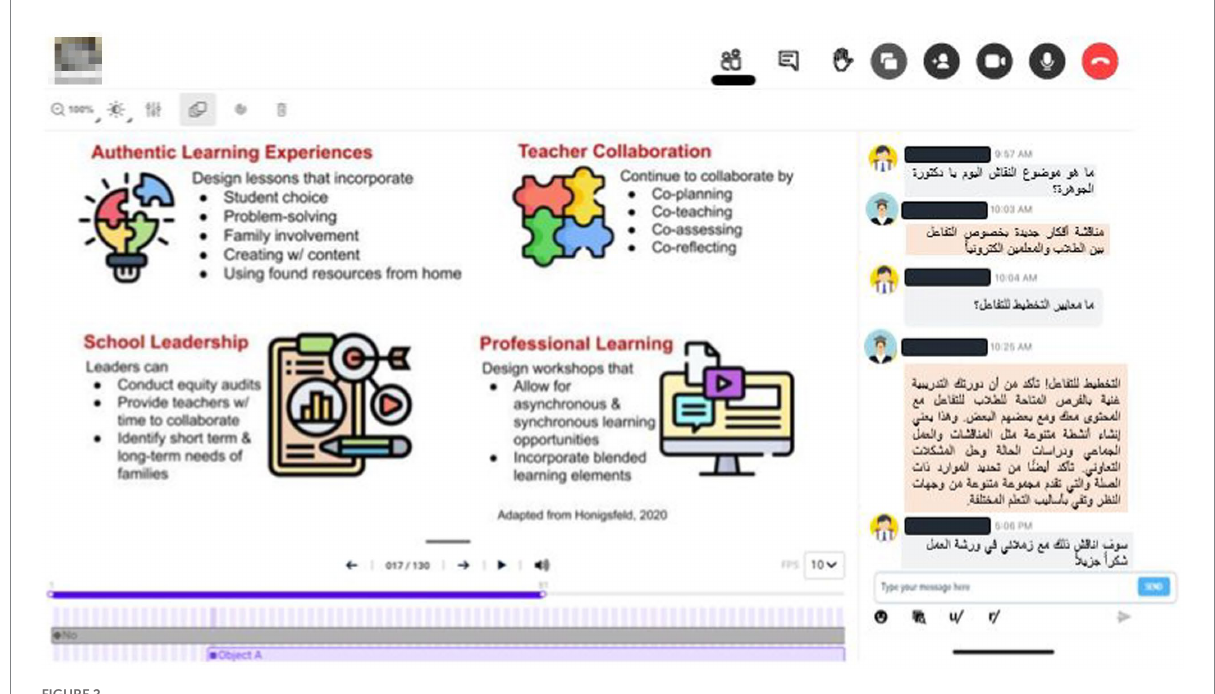
FIGURE 2 Virtual classroom at Bisha University using Blackboard learning management system